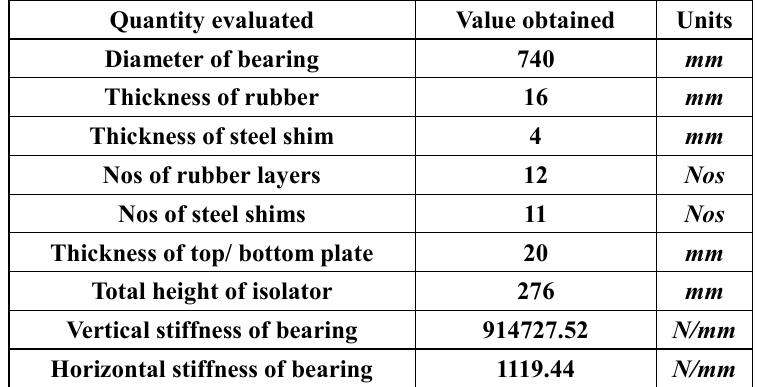
Geometric parameters of laminated rubber